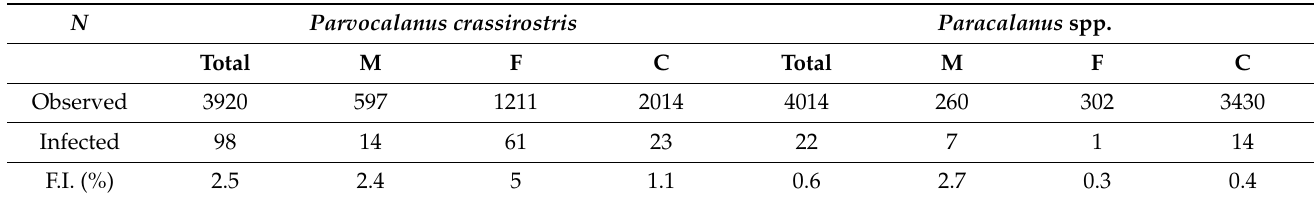
Table 1. The total amount of examined and infected copepods for each sex and developmental stage for Parvocalanus crassirostris and Paracalanus spp. and the respective frequency of infection (F.I.). M: adult male; F: adult female; C: juvenile copepodid, stages I to V.